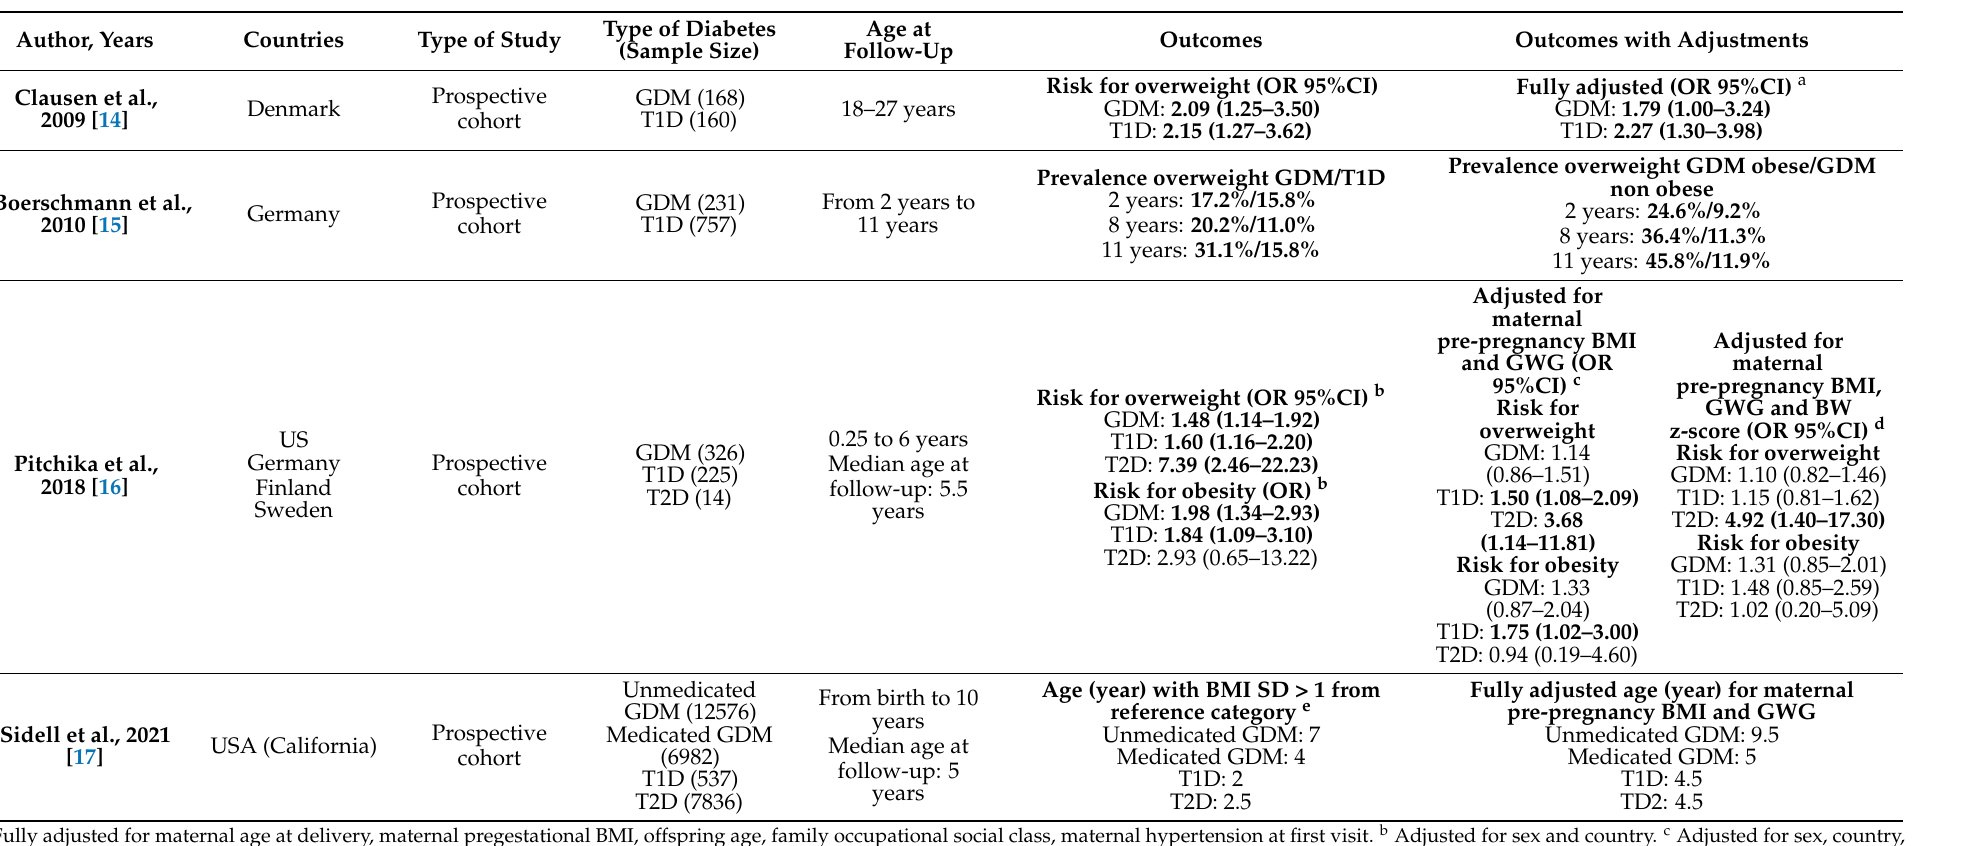
Table 1. Risk for overweight/obesity according to the type of maternal diabetes during